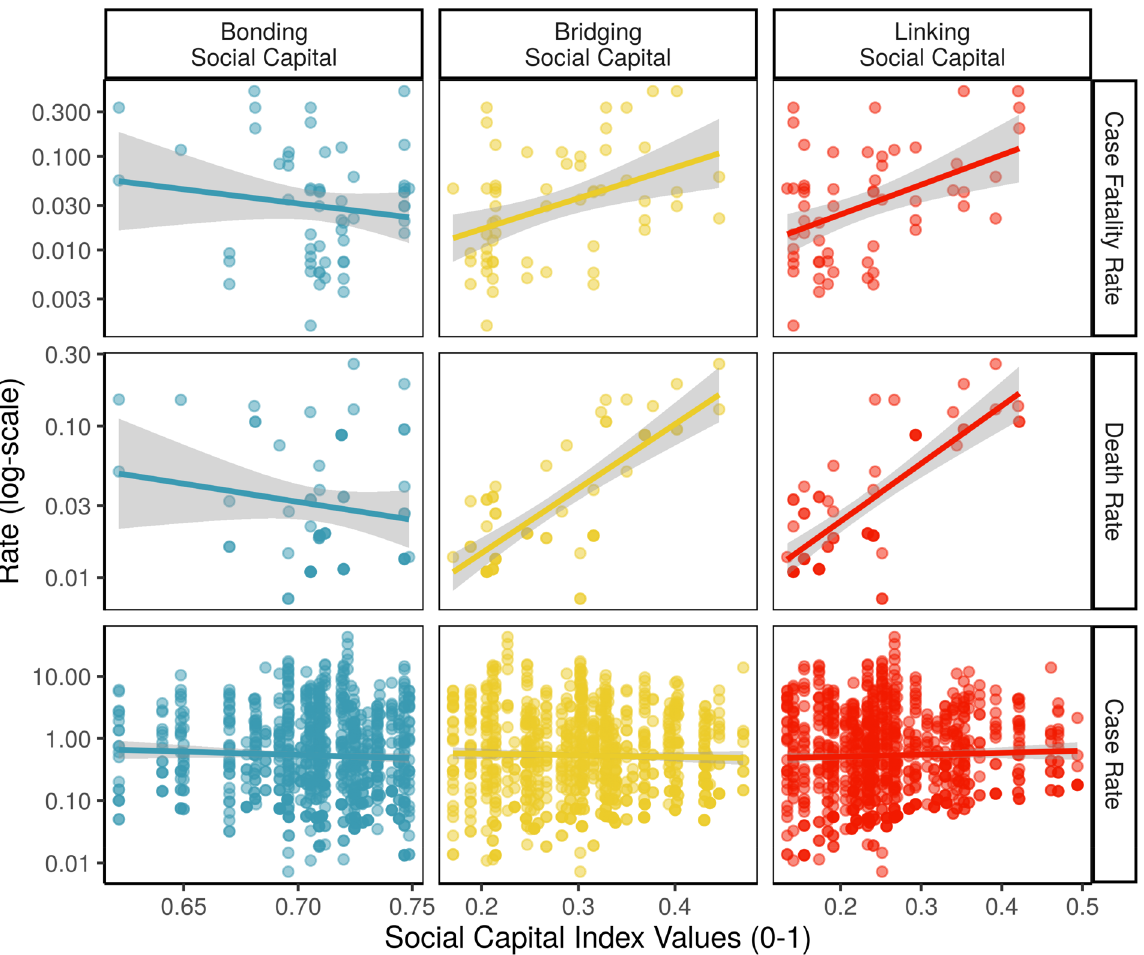
Figure 4. Social capital vs. COVID case rates and case fatality rates (in prefectures with active COVID